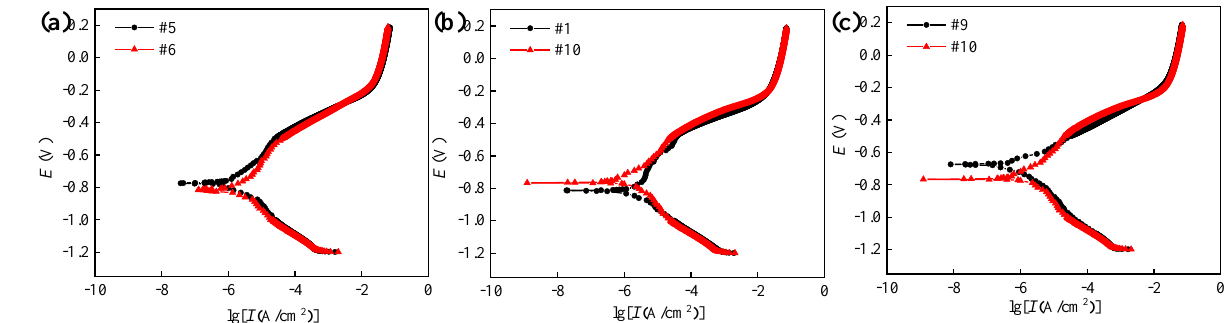
Figure 15. Nyquist plots and Bode plots of samples obtained in comparative experiments: ( a ) #5 and #6, ( b ) #1 and #10, and ( c ) #9 and #10.